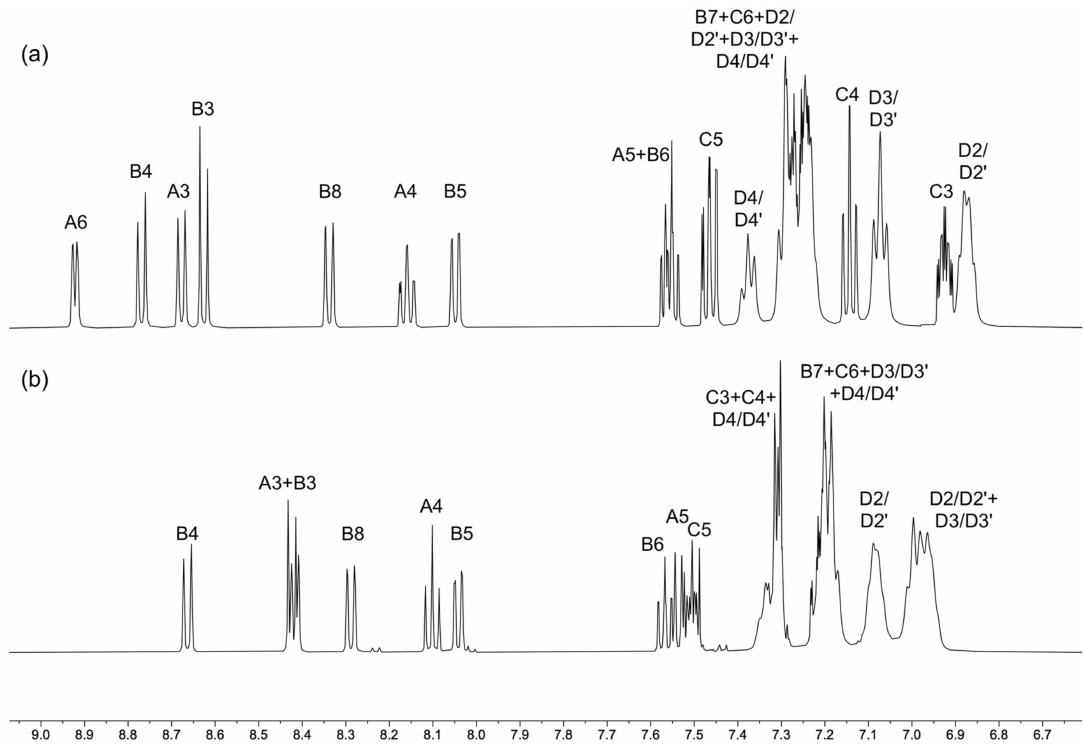
Figure 1. Comparison of the aromatic regions of the 1 H NMR spectra (500 MHz, acetone- d 6 , 298 K)